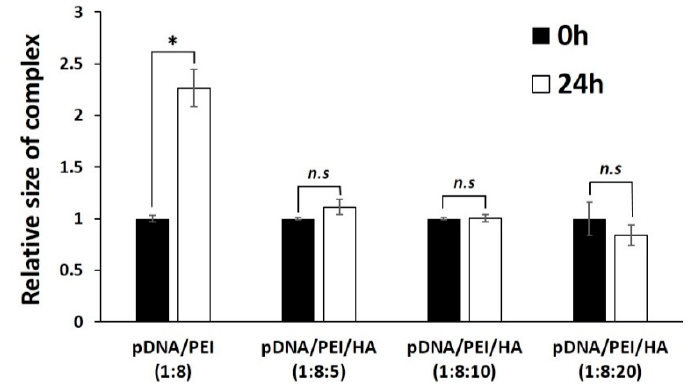
Figure 3. The size stability of each nanocomplex after incubation for 24 h. * p < 0.05, n.s = not significant.